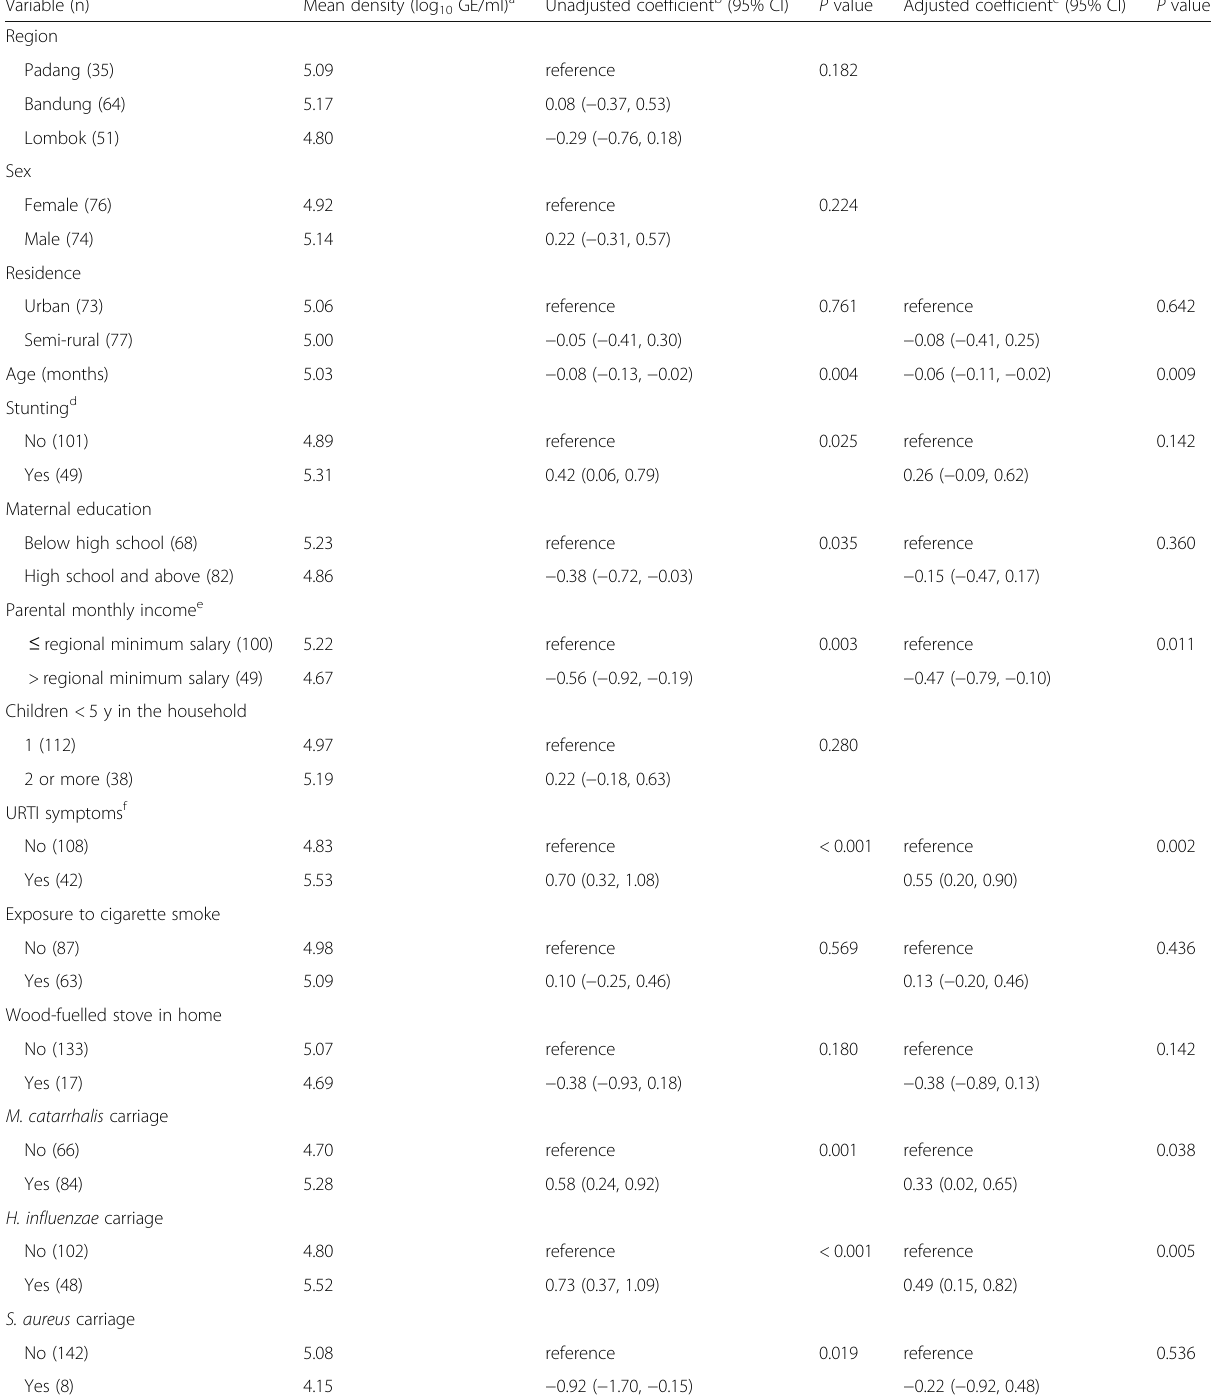
Table 3 Linear regression analysis of factors associated with S. pneumoniae density in children who are carriers ( n =